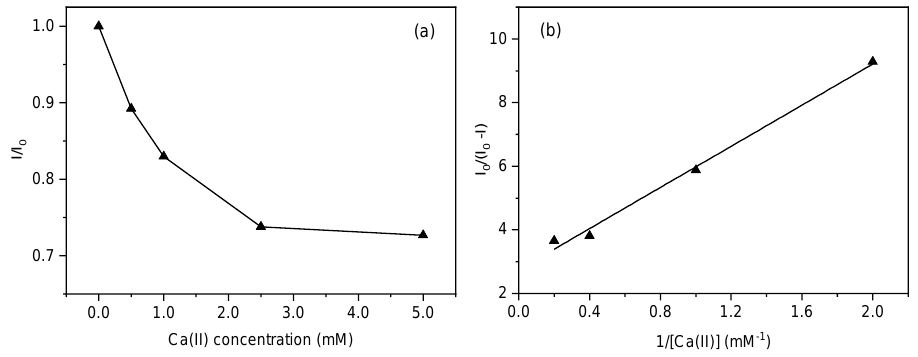
Figure 7. SyF quenching of HA by Ca(II) ( a ) and plots of the modified Stern-Volmer Equation ( b ).